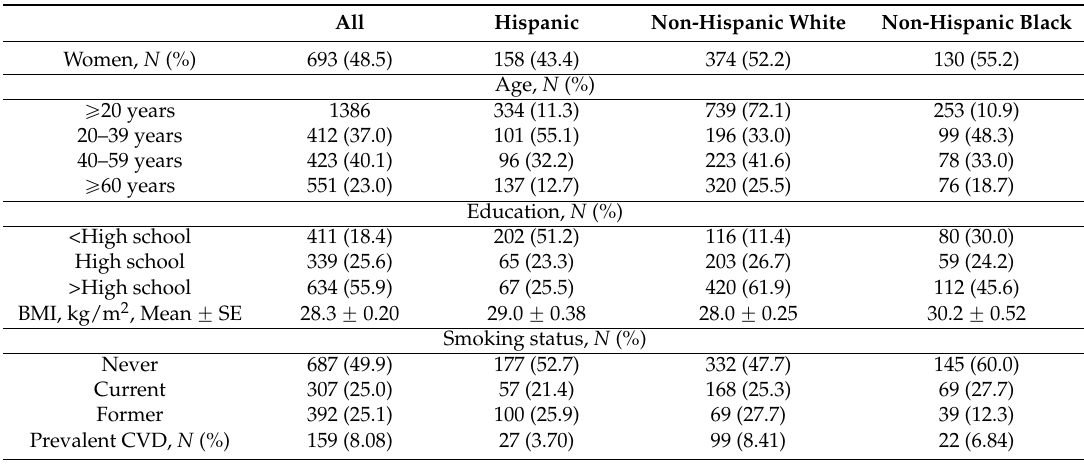
Table 1. Characteristics of study participants, N = 1386.